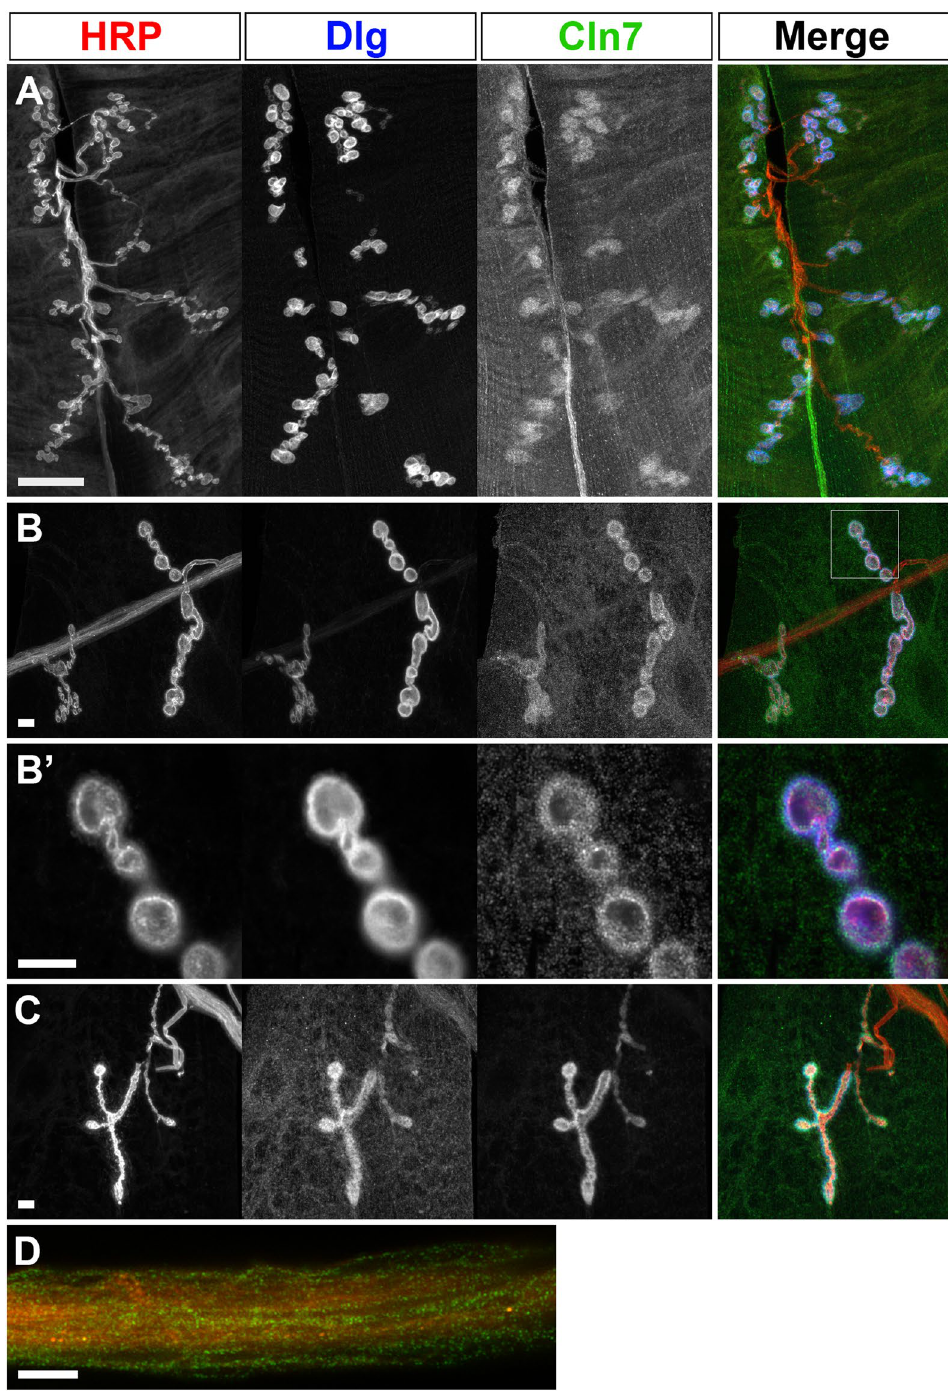
Figure 2. Cln7 localizes to a vesicular compartment at the post-synaptic membrane. ( A,B ) Late larval NMJs from a YFP-Cln7 knock-in reporter line fixed and stained for the neuronal plasma membrane (anti-HRP, red), the sub-synaptic reticulum membrane (anti-Dlg, blue) and for YFP-Cln7 (anti-GFP, green). YFP-Cln7 is restricted to the post-synaptic muscle cell at the larval neuromuscular junction. ( A ) Show NMJ6-7 and ( B ) shows NMJ4b. The boxed region in B was imaged at higher resolution in B’. Distinct Cln7 + vesicles are concentrated within and around the sub-synaptic reticulum. ( C ) A Myc-BioID-Cln7 fusion protein is still recruited to the sub-synaptic reticulum when overexpressed from a cDNA construct in the muscle lacking the endogenous 3’UTR. Anti-Myc (green) was used to visualize the Cln7 fusion. ( D ) YFP-Cln7 is also expressed in the ensheathing glia that wrap axons in the nerves. Transverse optical section through intersegmental nerve 1b stained with anti-HRP (neurons, red) anti-GFP (YFP-Cln7, green). Bar = 10 μ m ( A , D ); 5 μ m ( B , C